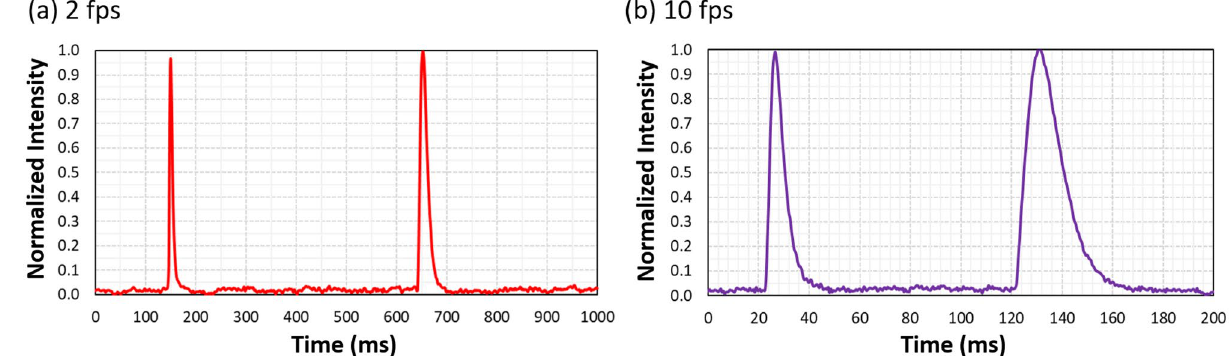
Figure 3. Time-resolved intensity measurements for the SLM between polarizers at 45 ◦ . Two gray levels are sequentially addressed to provide a retardance of π and 3π ( a ) every second and ( b ) every 0.2